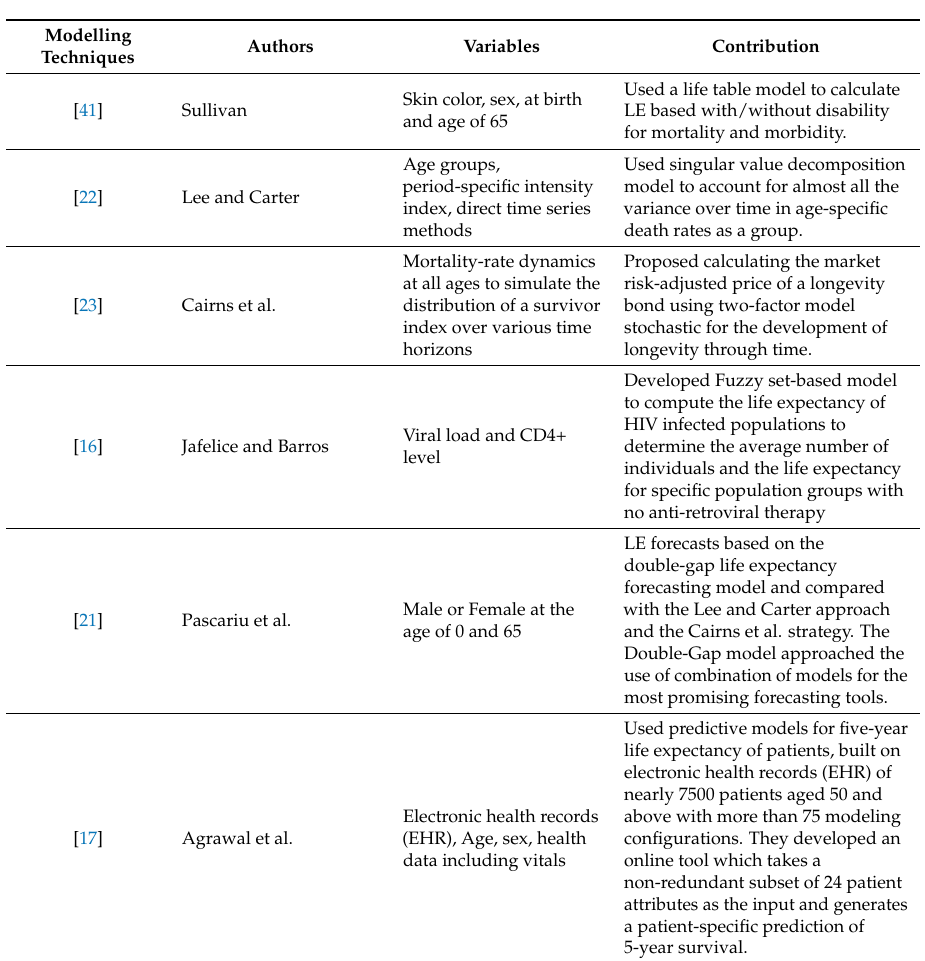
Table 2. Summary of Modelling